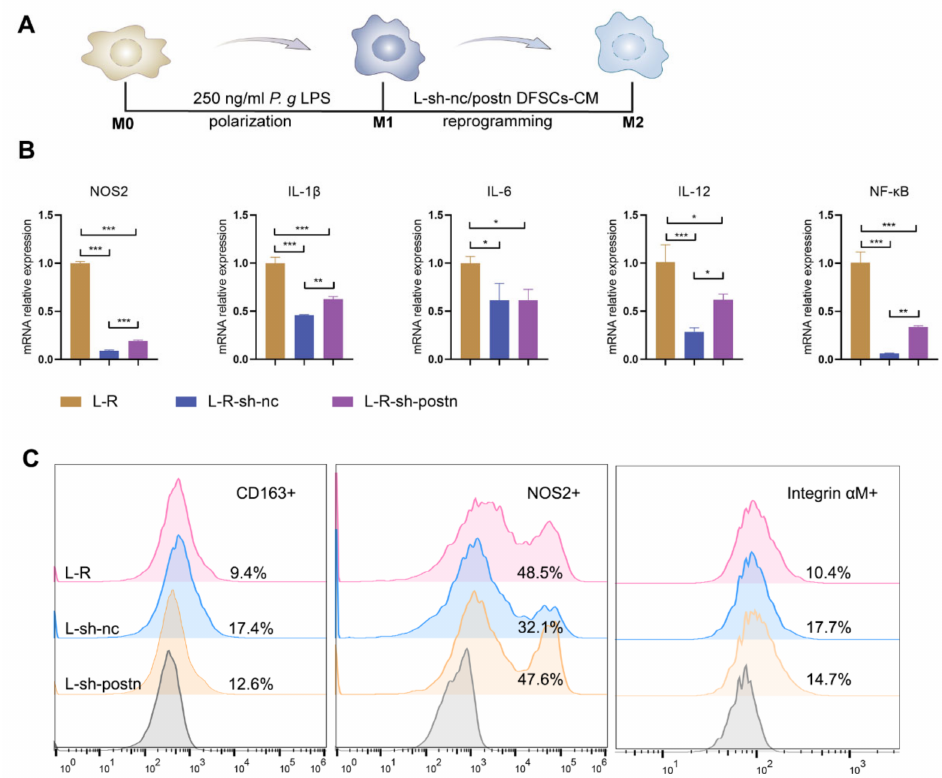
Figure 4. Silencing periostin inhibited the reprogramming of macrophages to the M2 type by DFSCs. ( A ) Diagram of the strategy for validating that periostin affects the ability of DFSCs to reprogram M1 to M2 macrophages. ( B ) qRT-PCR for M1 marker and pro-inflammatory factors in macrophages. The data were analyzed by one-way ANOVA and Bonferroni post hoc test (n = 3). ( C ) Flow cytometric analysis for surface marker expression on macrophages. * p < 0.05; ** p < 0.01; *** p < 0.001. Error bars represent means ±